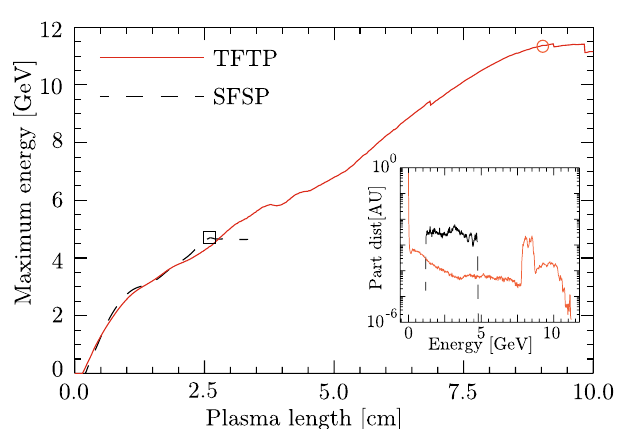
Figure 3. Time evolution of maximum energy of the accelerating electron bunch with 1PW laser. The solid line shows the energy gain from the TFTP, while the dashed line represents the energy gain from the single frequency single pulse (SFSP). The inset shows the electron spectra for the two cases at the plasma position of the maximum energy ( ⊙ : TETP , ⊡ : SFSP ). The results are obtained with 2D PIC